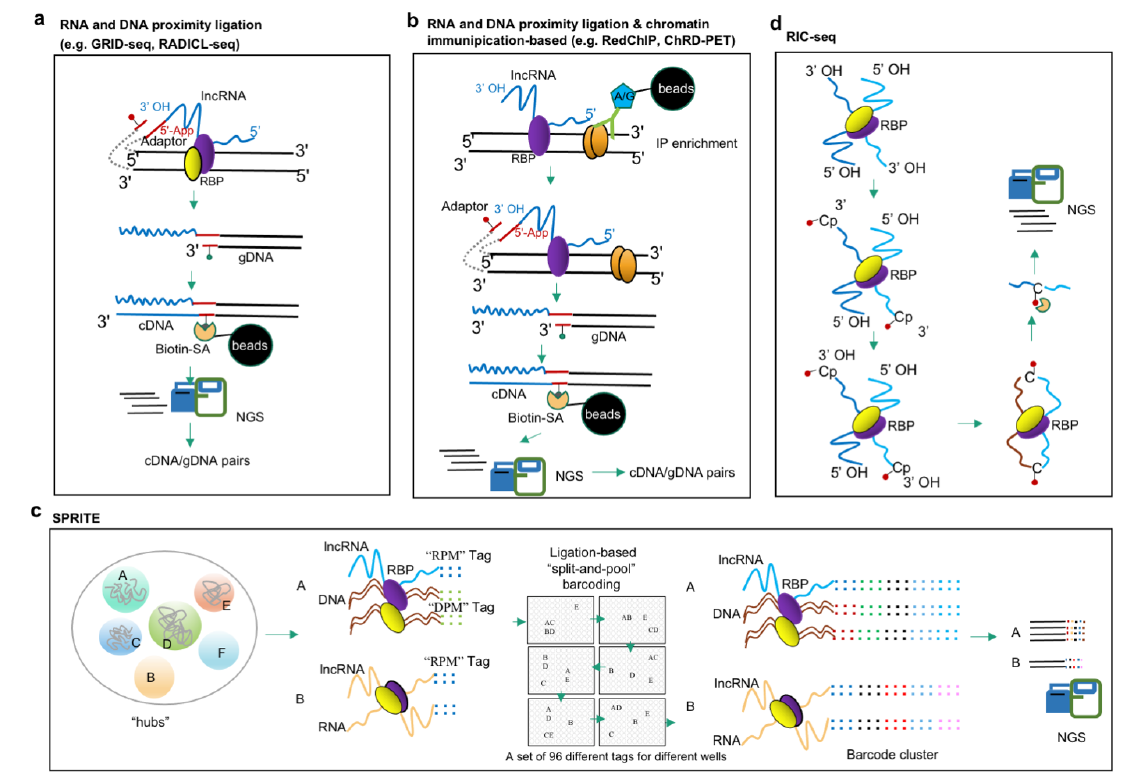
Figure 2. Methodologies for detecting lncRNA–DNA, and lncRNA–RNA interactions. ( a ) RNA and DNA proximity ligation-based approaches (e.g., GRID-seq, RADICL-seq) determines lncRNA–DNA interactions by in vivo proximity ligation of RNA and DNA using modified bridge linker (refer to Figure 3 for details), the resulting chimeric RNA–DNA were reversed transcribed and purified with biotin-SA system for NGS library construction and sequencing. ( b ) RNA and DNA proximity ligation and chromatin immunoprecipitation-based (e.g., RedChIP, ChRD-PET) combines RNA–DNA proximity ligation and chromatin immunoprecipitation (IP) enrichment for identifying RNA-chromatin interactions mediated by a particular protein or a particular histone modification. ( c ) SPRITE approaches map the spatial organization of RNA and DNA by repeatedly “split-and-pool” barcoding ligation over five rounds with a set of “RNA Phosphate Modified” (RPM), “DNA Phosphate Modified” (DPM), “Odd”, “Even” and “Terminal” tags. ( d ) RIC-seq globally captures protein-mediated RNA–RNA proximal interactions in vivo by labeling the 3 (cid:48) end of interacting RNAs with pCp-biotin (biotinylated cytidine (bis) phosphate) and ligated to generate chimeric RNAs for